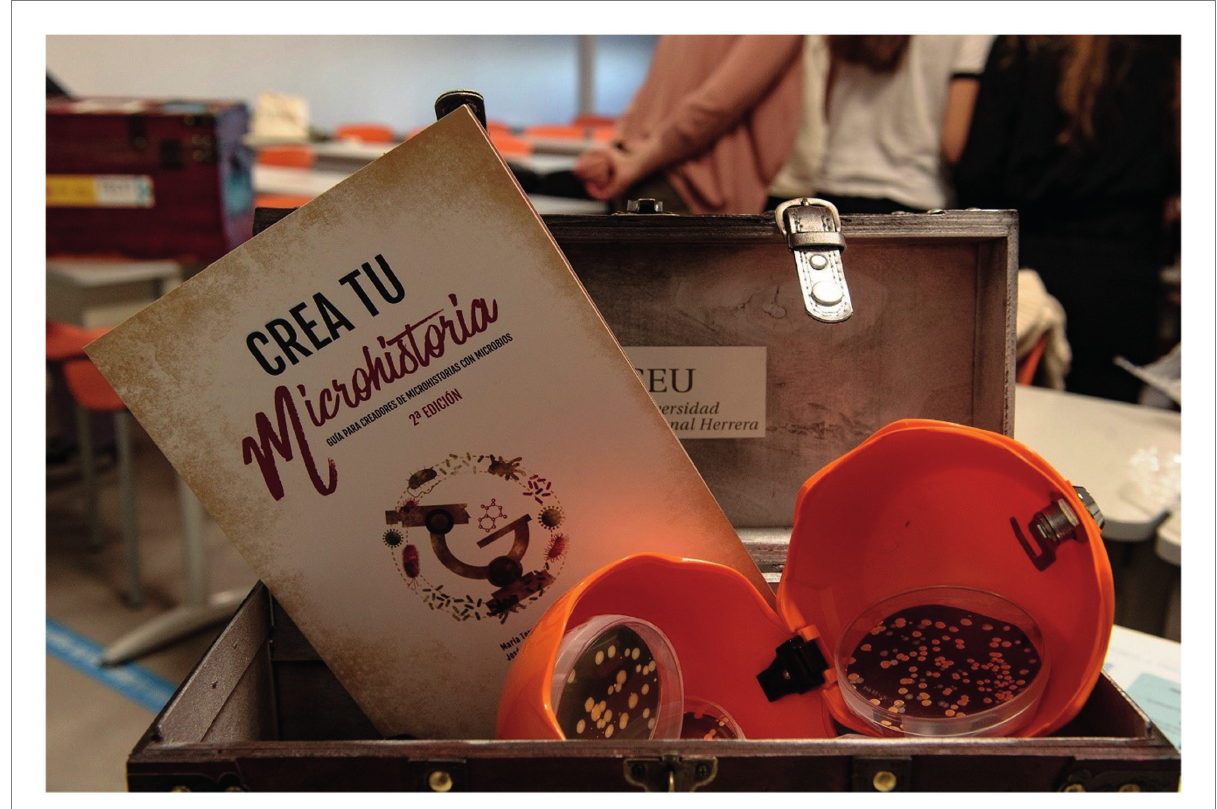
FIGURE 7 Box and objects for testing the escape box on AMR, designed by the SWICEU